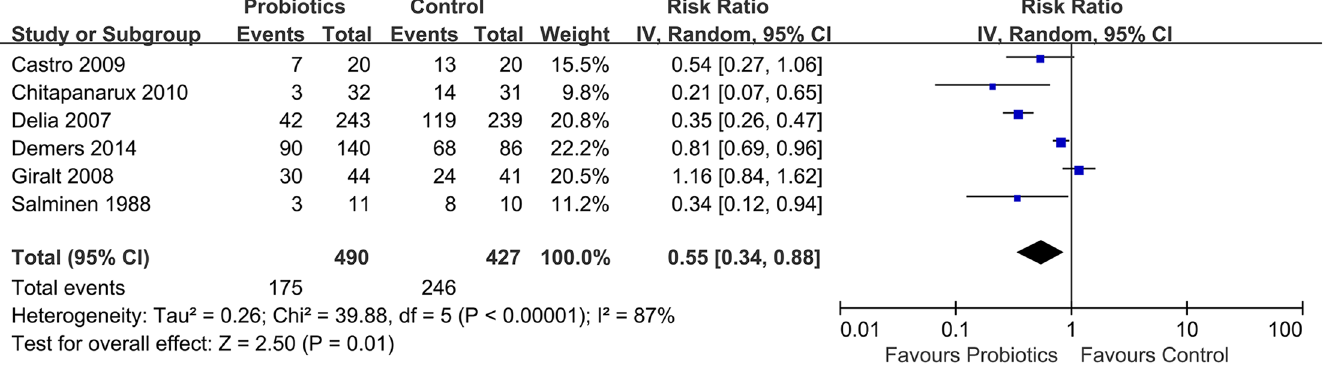
Fig 4. Effect of probiotics on prevention of radiation-induced diarrhea compared with placebo.